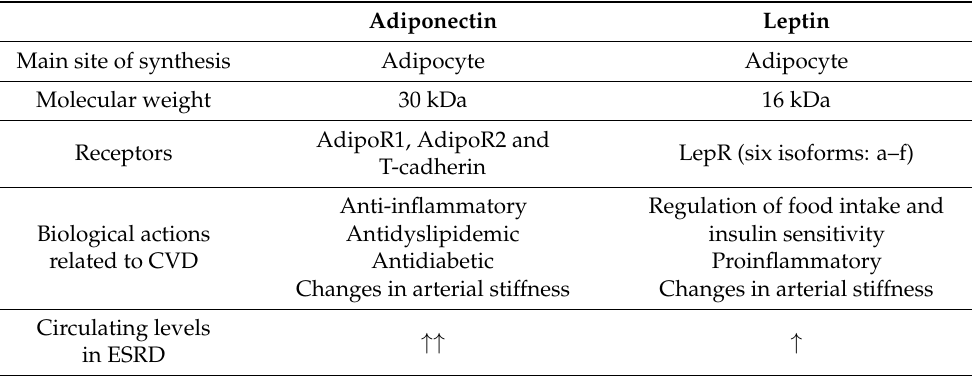
Table 1. Adiponectin and leptin